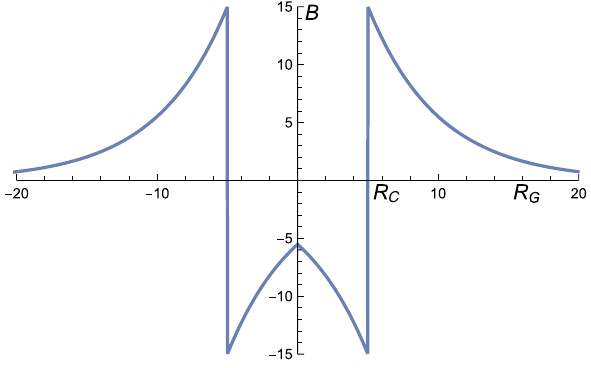
Fig. 5 One dimensional model of the magnetic field of a galaxy used in the calculation as a function of distance